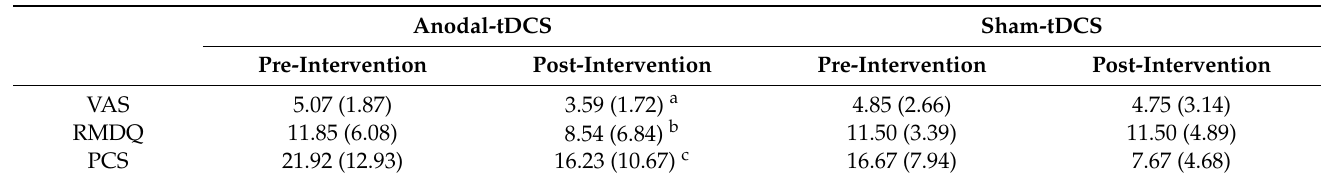
Figure 4. ( A ) Pain intensity, ( B ) Roland Morris Disability Questionnaire (RMDQ), and ( C ) Pain Catastrophising Scale (PCS) total scores (with standard error of the mean error bars) at pre ‐ and post ‐ intervention by group.